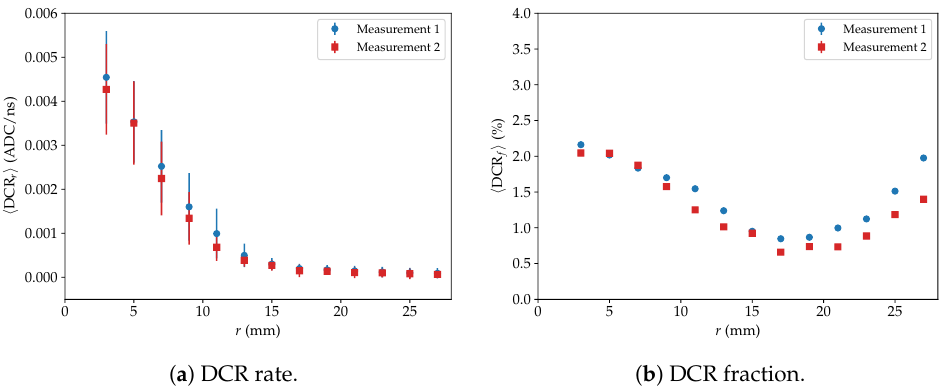
Figure 12. Radial dependence of ( a ) azimuthal positions. Error bars represent the standard deviations of the DCR distributions. Another way of quantifying the DCR effect is to convert the mean DCR rate to an average DCR fraction